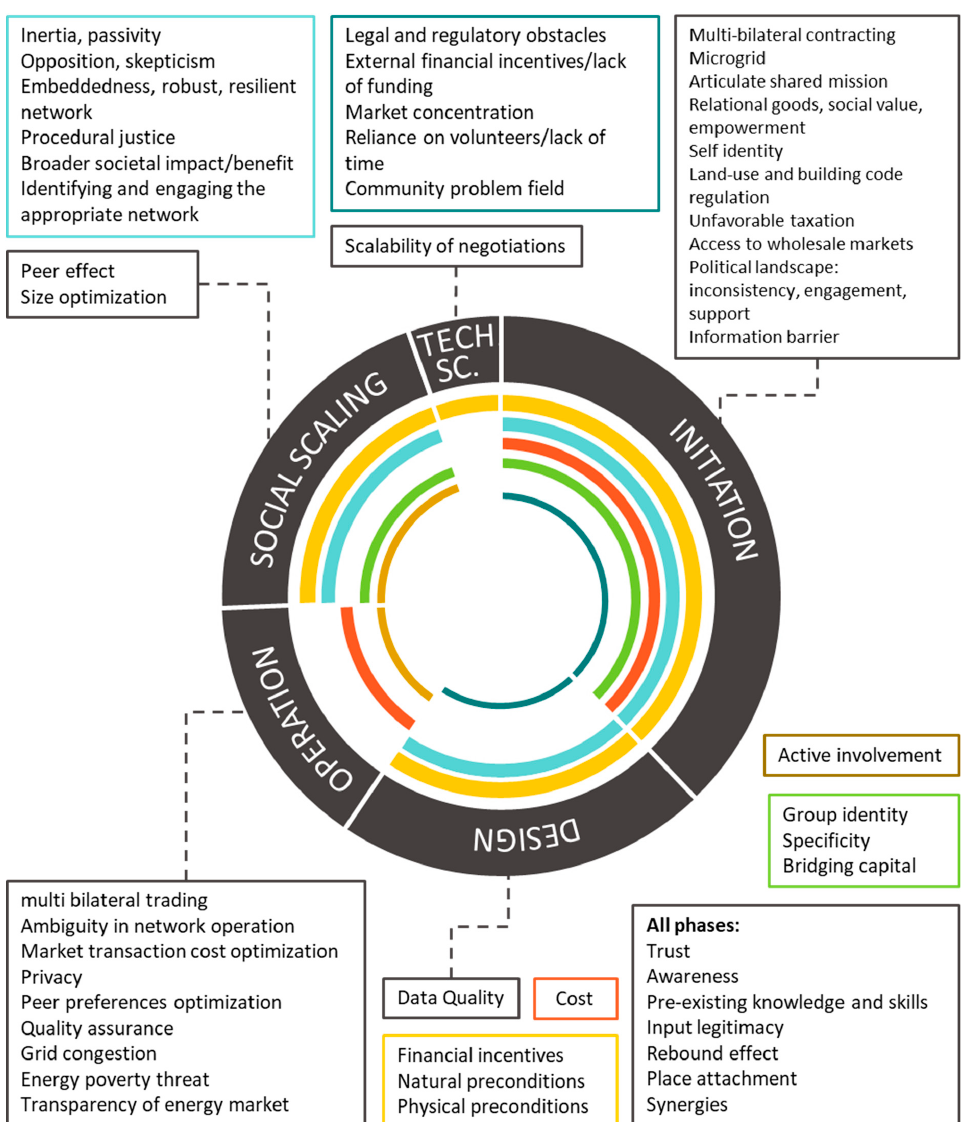
Figure 22. Energy community lifecycle wheel: distribution of progression factors by lifecycle phase.